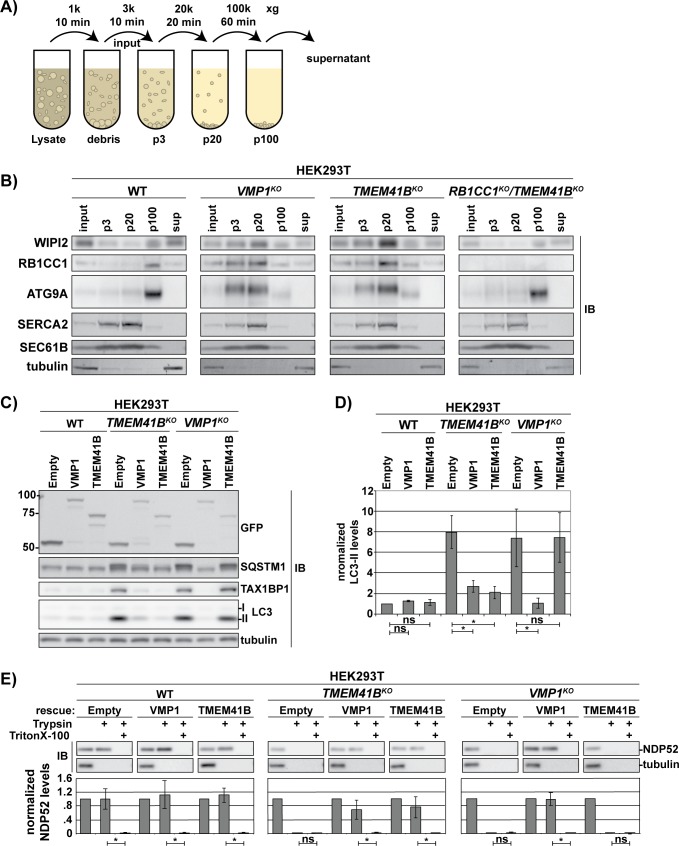
TMEM41B shares structural homology and functional redundancy with VMP1.(A) Schematic for vesicle fractionation protocol. (B) WT and indicated HEK293T knockout cells were fractionated as outlined in panel A. Fractions were resolved by SDS-PAGE followed by IB with indicated antibodies. Membrane fractions are loaded as 15X concentrate. (C) tfEmpty, tfVMP1, or tfTMEM41B expression constructs were integrated at the AAVS1 locus in WT and HEK293T knockout cells. Cell lysates were normalized by total protein prior to resolution by SDS-PAGE and IB with indicated antibodies. LC3-II levels relative to WT (tfEmpty) cells are indicated under each lane (normalized to tubulin). (D) Quantitation of LC3-II levels shown in C. LC3-II levels in each lane were normalized to tubulin. LC3-II levels in WT (Empty) cells were set to 1. Bar graphs show the mean ± SD of each sample from 3 independent experiments; p-values were determined using a student t test. *p < 0.02. (E) HEK293T cells from C were treated for 18 h with 100 nM BafA1 prior to gentle, mechanical lysis. The corresponding cell extracts were treated as indicated prior to being resolved by SDS-PAGE and analyzed by IB with indicated antibodies. NDP52 serves as a representative autophagy target; tubulin is unincorporated and serves as a control for proteolysis. Bar graphs show the mean ± SD of each sample from 3 independent experiments; p-values were determined using a student t test. *p < 0.02. Related to S7 Fig. Underlying data for all summary statistics can be found in S1 Data. AAVS1, adeno-associated virus integration site 1; ATG, autophagy-related; BafA1, Bafilomycin A1; GFP, green fluorescent protein; HEK, human embryonic kidney; IB, immunoblotting; LC3, microtubule-associated protein 1 light chain 3B; NDP52, nuclear dot protein 52; ns, not significant; RB1CC1, RB1 Inducible Coiled-Coil 1; SQSTM1, sequestosome 1; Sup, supernatant; TAX1BP1, tax1 binding protein 1; tf, tandem-fluorescent; TMEM41B, transmembrane protein 41B; VMP1, vacuole membrane protein 1; WIPI2,; WT, wild-type.